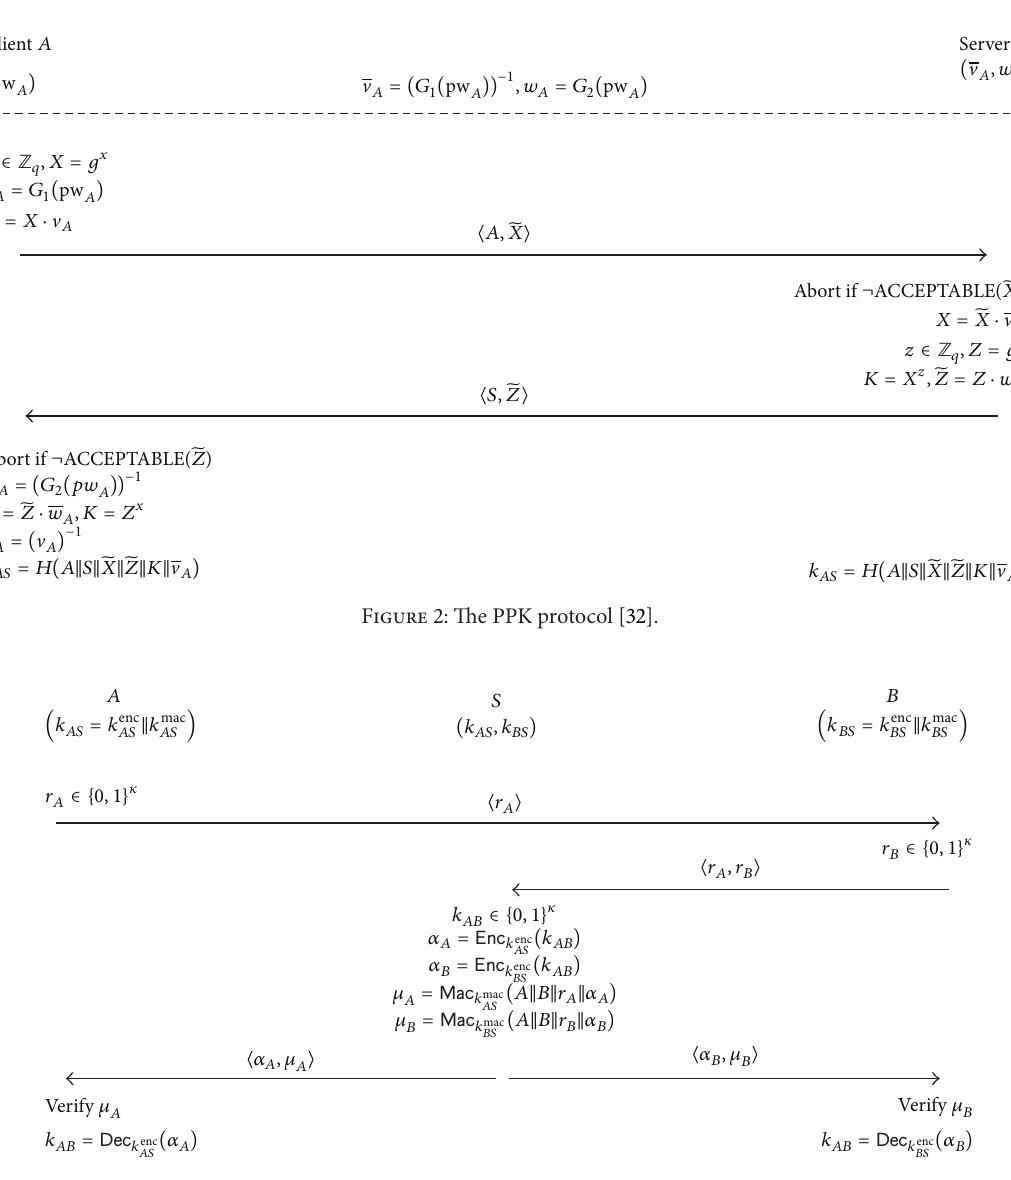
Figure 3: The 3PKD protocol